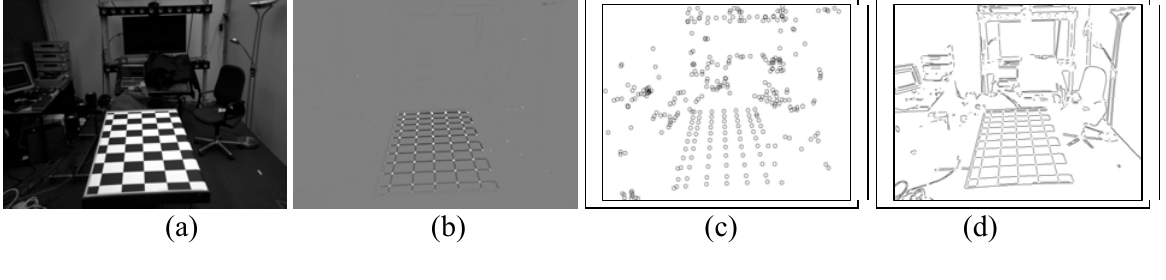
Figure 16. (a) original image (b) Harris operator (c) detected corners (d) edges of the objects (e) Hough transform (f) Hough transform of the principle lines (g) principle line (h) sets of lines (i) lines which are coherent with the corners detected (j) final lines (k)